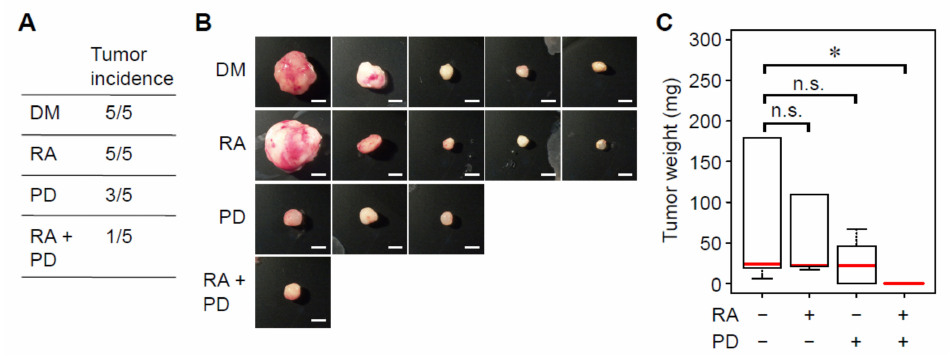
Figure 5. ERK inhibition and RAR activation synergistically decrease tumorigenicity of breast cancer cells. ( A – C ) Tumorigenicity of MDA-MB-231 breast cancer cells treated with or without RA and/or a MEK inhibitor (PD0325901) was evaluated by a tumor xenograft model in immunocompromised mice ( n = 5). ( A ) The number of mice that developed tumors. ( B ) Representative images of the developed tumors. Scale bars: 4 mm. ( C ) Weight of tumors. *, p < 0.05 (Krukal-Wallis test followed by Wilcoxon rank sum tests). n.s.: not